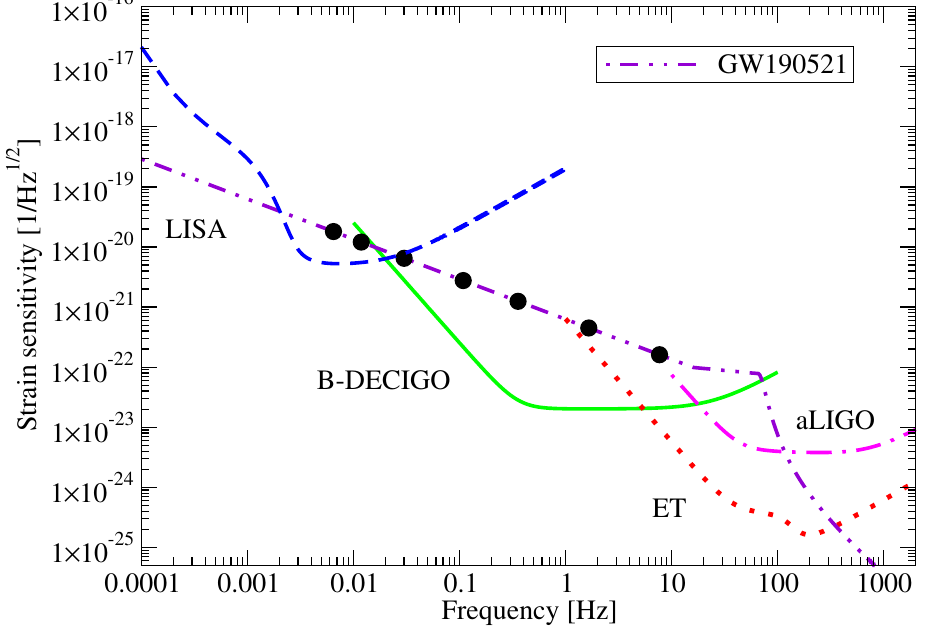
Figure 1. Strain sensitivity curves for the ground-based aLIGO and a next-generation (3G) detector: Einstein Telescope (ET) and space-based B-DECIGO and LISA, together with the GW amplitude of a GW190521-like nonprecessing, quasicircular BBH. We use the median values in Table 1 as source parameters. The noise power spectral density (PSD) for each GW detector is given in Section 2.1, and the spectral density of the BBH amplitude is obtained by the nonspinning, IMR amplitude model in Section 2.3. As a reference, we mark with the black dots with 5 years, 1 year, 1 month, 1 day, 1 h, 1 min, and 1 s before the merger time (1) from the left to the